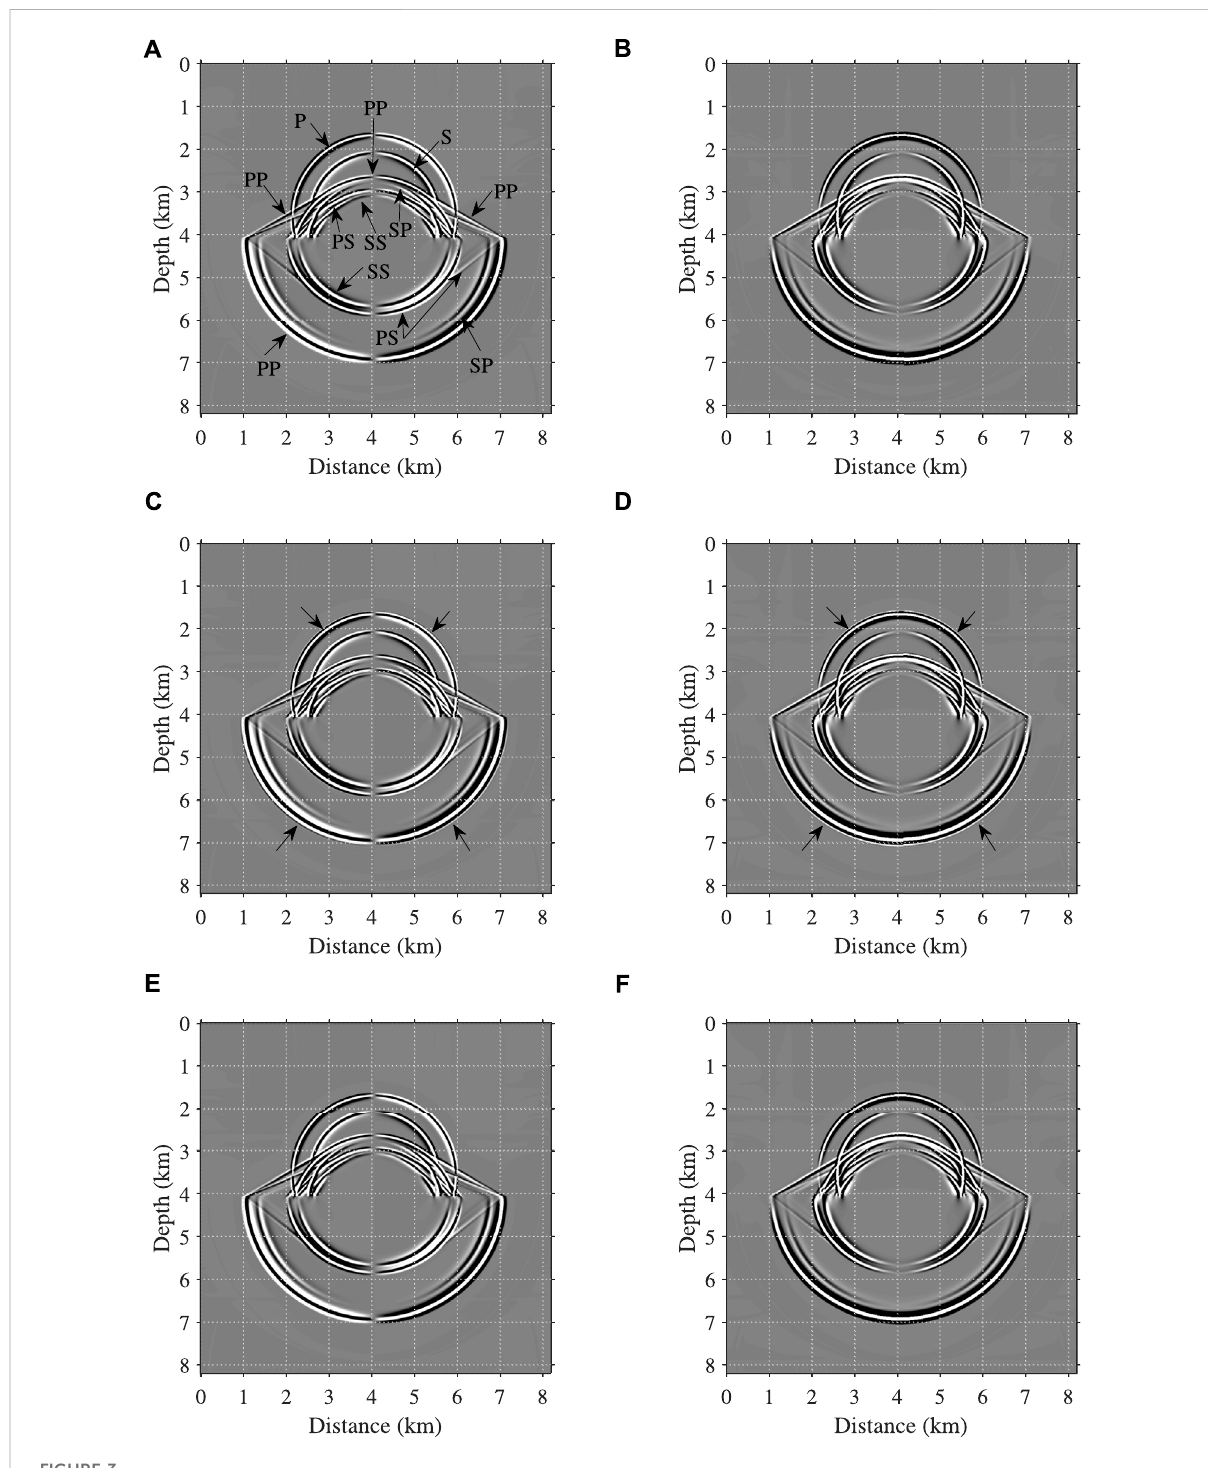
FIGURE 3 Snapshots of v x : (A,C,E) , and v z : (B,D,F) at t = 1 s by low-rank scheme with Δ t = 2.5 ms (A,B) , SGPS with Δ t = 1 ms (C,D) , SGPS with Δ t = 0.5 ms (E,F) .Thesymbol ‘ PS ’ denotesre fl ectionortransmissionSwaveswithincidentPwaves.Thephysicalmeaningsof ‘ PP ’ , ‘ SS ’ and ‘ SP ’ canbeunderstood in the same way. The arrows in (C,D) indicate the time